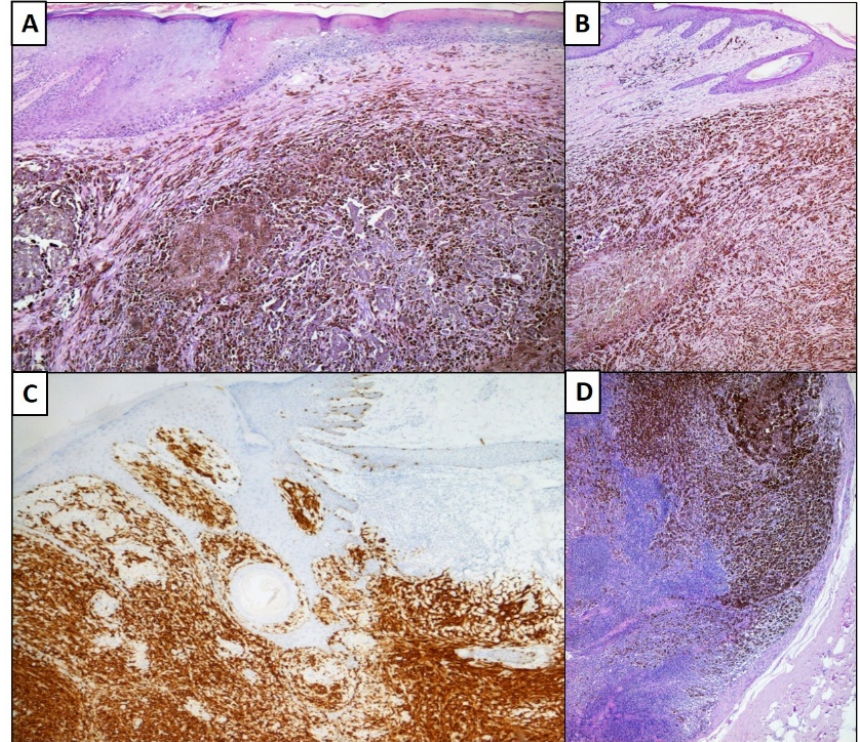
Figure 1. ( A ) Skin and subcutis including intensely pigmented melanocyte proliferation. (Hematoxylin-Eosin, Original Magnification: 4×). ( B ) Histological detail of melanocyte proliferation consisting of variously intertwined cells, with evident presence of melanic pigment. (Hematoxylin-Eosin, Original Magnification: 10×). ( C ) Immunohistochemical preparation with anti-Melan-A antibody which highlights the melanocyte proliferation in question (Immunohistochemistry, Original Magnification: 4×). ( D ) Detail of micrometastases in the sentinel lymph node (Hematoxylin-Eosin, Original Magnification: 4×).